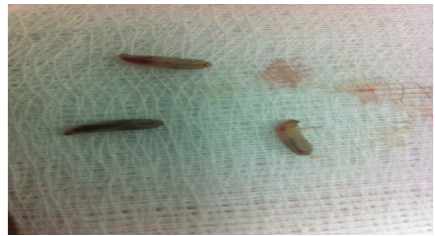
Figure 2: Three alive larvae removed from the patient